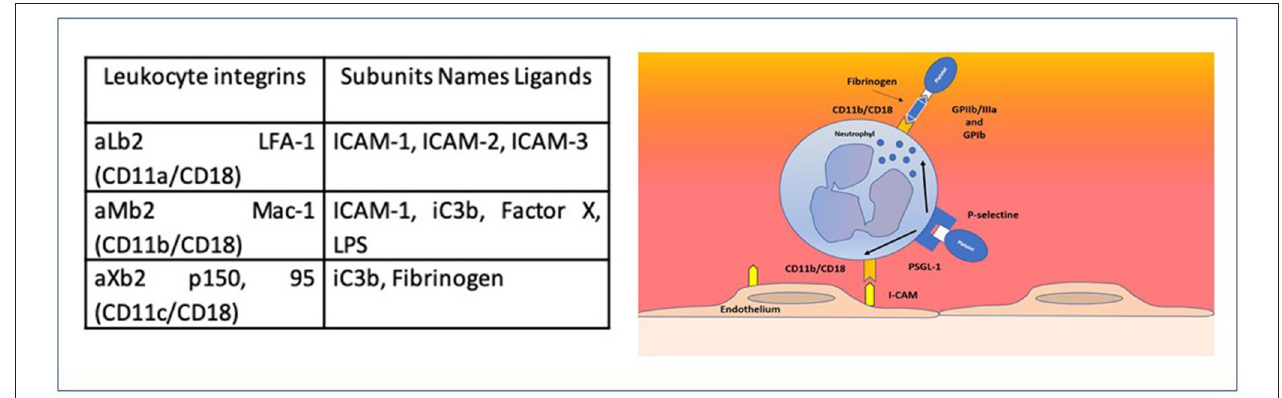
FIGURE 1 | Families of adhesion receptors and their counter receptors. CD11b/CD18 expressed on activated neutrophils supports the interaction between platelets GPIIB/IIIA and GPIb ( via fibrinogen) and with endothelium via